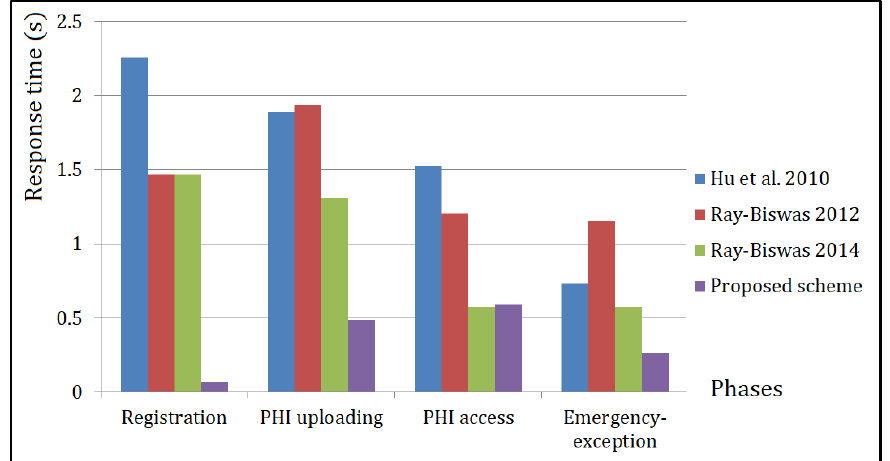
Figure 7. The response time of other related schemes in terms of registration phase, PHI uploading phase, PHI access and emergency-exception-handling phase.